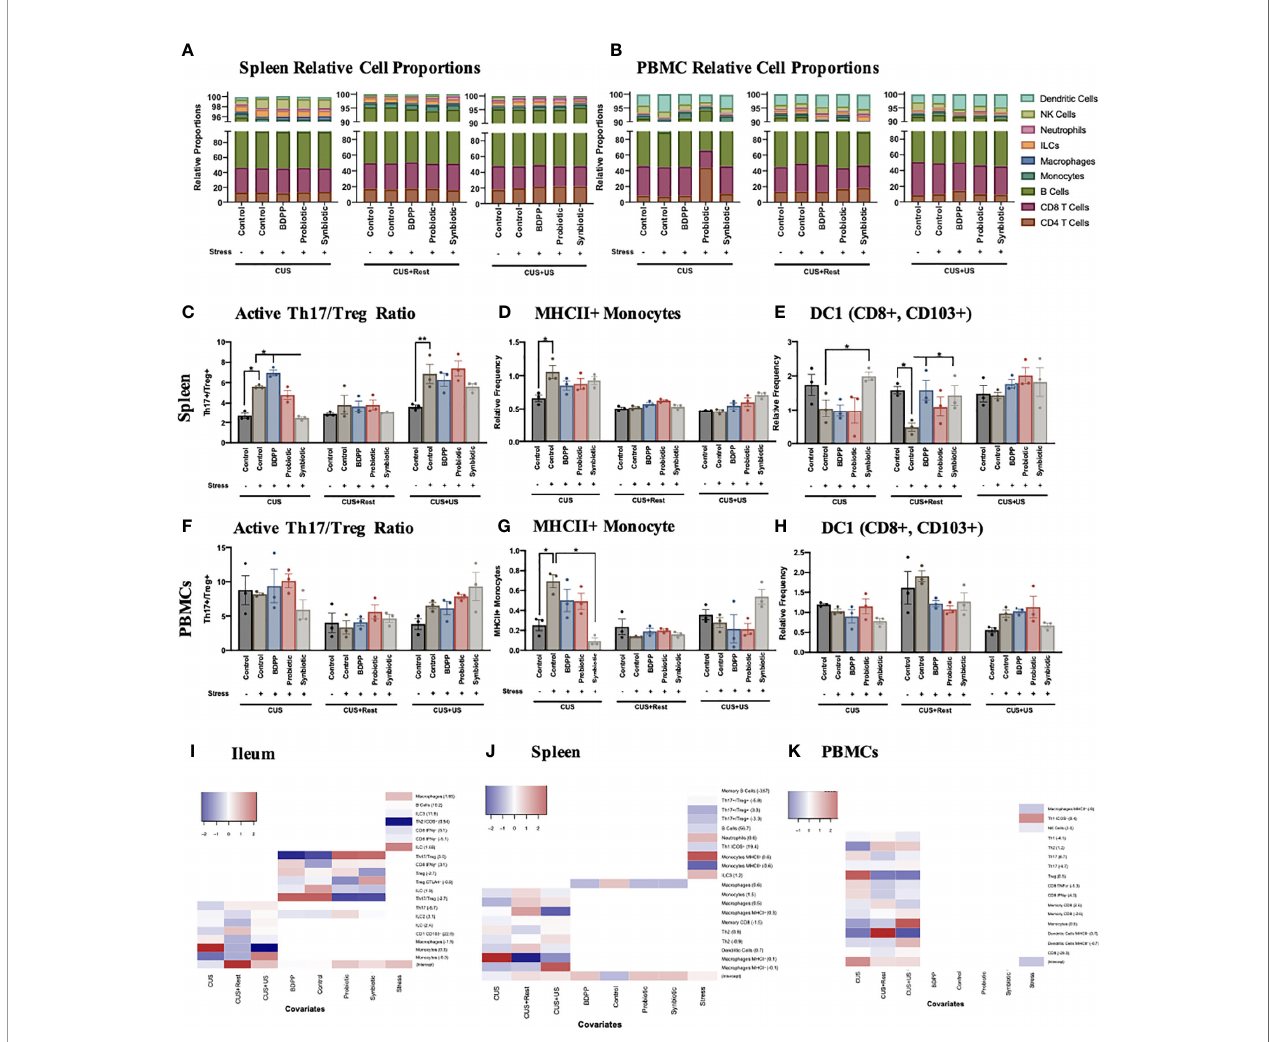
FIGURE 5 | Interaction between peripheral and central immune cell pro fi les determine stress-induced behaviors. Immunophenotyping of the major cell types in the (A) spleen and (B) PBMCs show little variation across time during the CUS protocol, which is also re fl ected in the viSNE plots ( Figure S9 ). Splenic cell frequencies re fl ect the activated (C) Th17/Treg ratio, (D) MHCII+ monocytes and (E) migratory CD103+ dendritic cells (DC)1 relative to total cell populations. PBMC cell frequencies of (F) Th17/Treg ratio, (G) MHCII+ monocytes and (H) migratory CD103+ dendritic cells (DC)1 relative to total cell populations are also shown. All cell frequencies have n = 3 mice +/- SEM with signi fi cance calculated with a one-way ANOVA and Tukey ’ s post-hoc analysis where *p < 0.05 and **p < 0.01. The cellular frequencies were associated to the individual study predictors (stress, timepoint and treatment) using a MARS additive model in the (I) ileum, (J) spleen and (K) PBMCs with the model hinge function in parentheses. The MARS term coef fi cient is represented as a heatmap with the higher coef fi cient represented with red color and the lower coef fi cient with